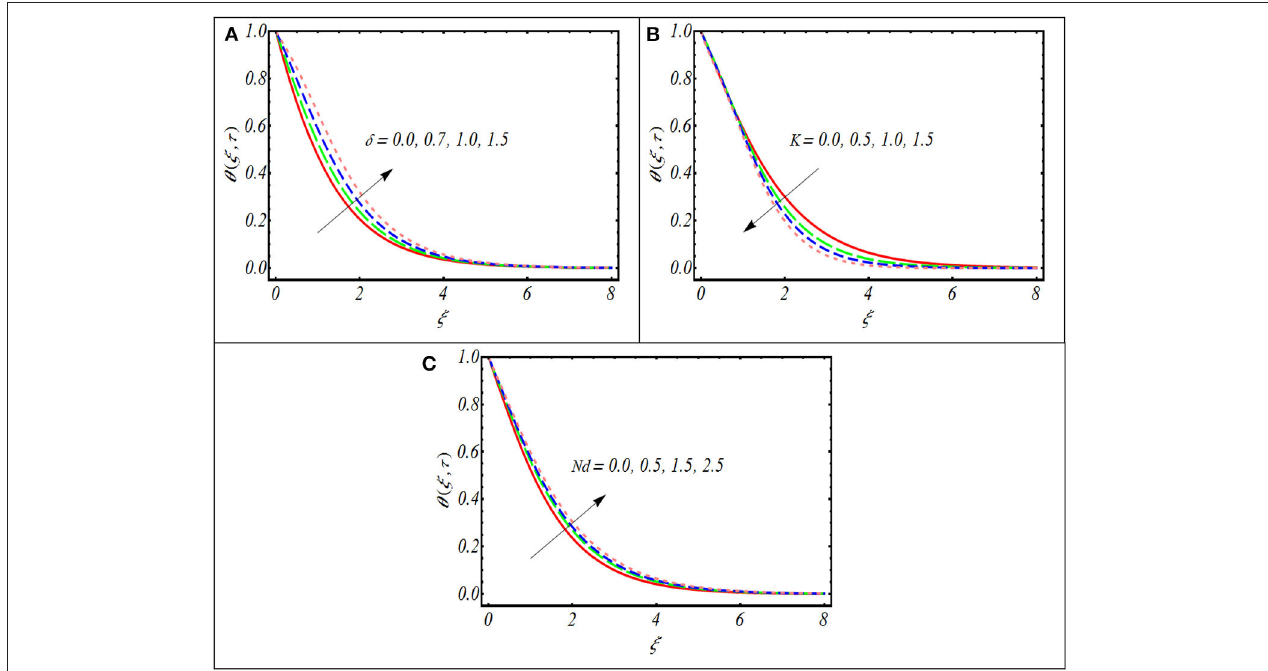
FIGURE 4 | Impact of (A) δ , (B) K , (C) Nd